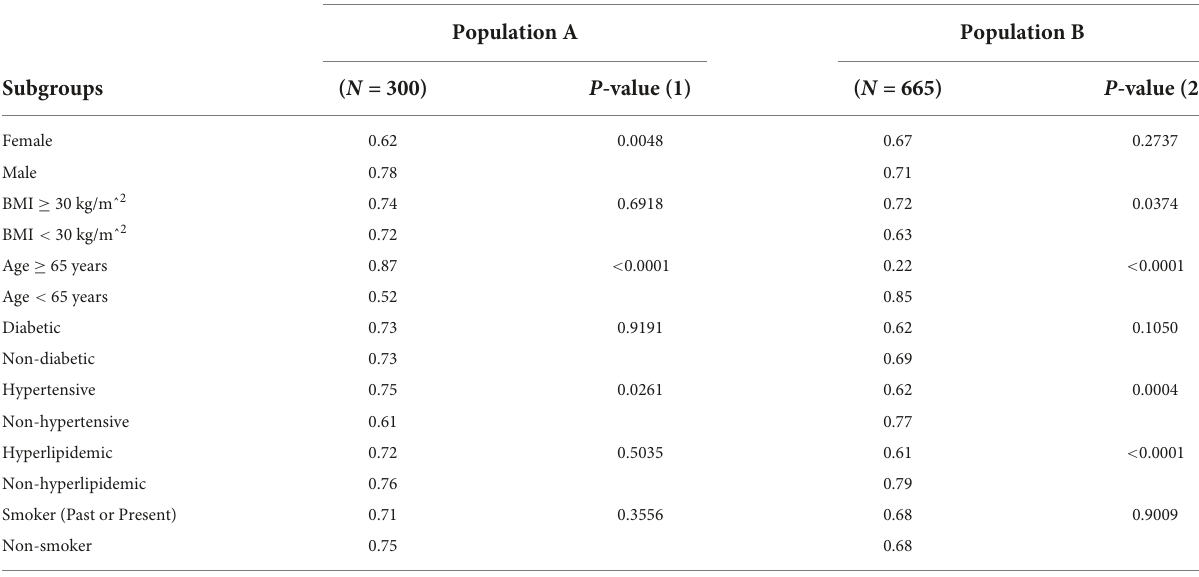
TABLE 6 Subgroup analyses of sensitivity and specificity performances in the validation